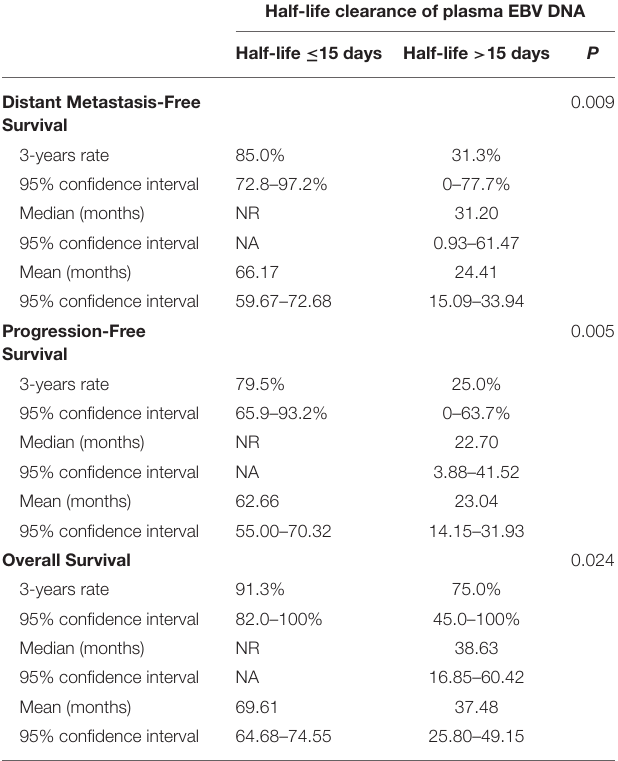
Frontiers in Oncology |